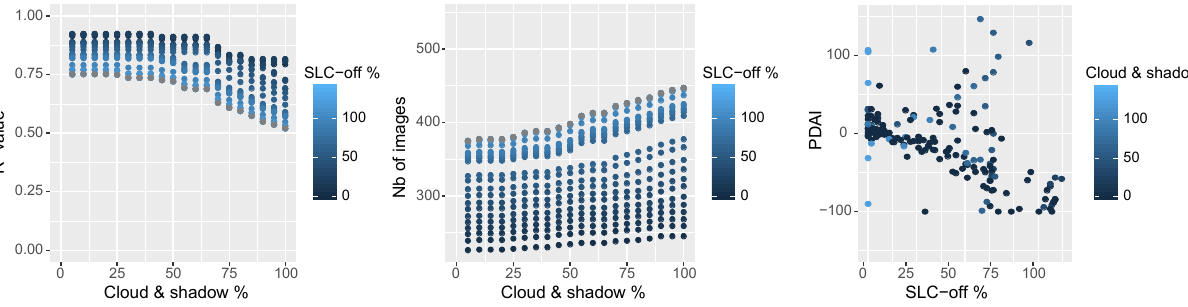
Figure 11. Change in R 2 (between field and remotely sensed surface areas), remaining number of Landsat scenes, and PDAI for increasing percentages of SLC-off and cloud and shadow pixels tolerated (Lake